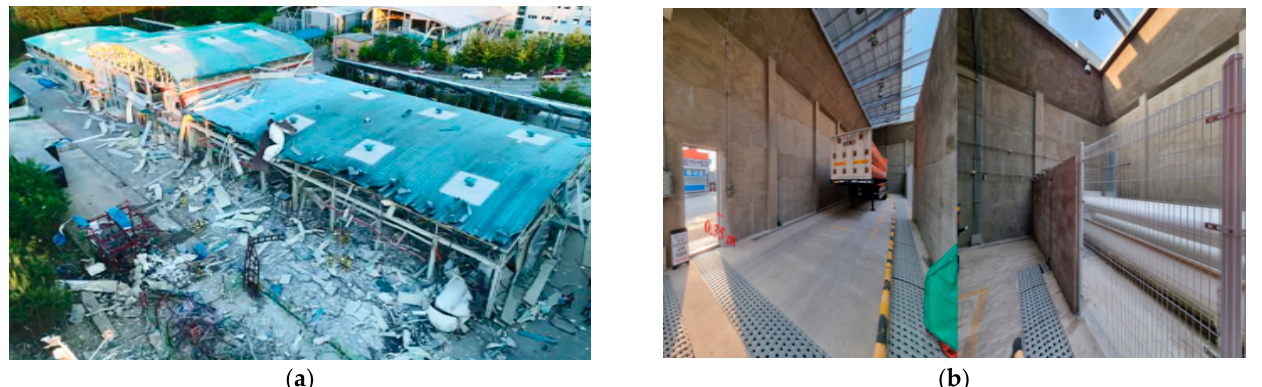
Figure 1. ( a ) Hydrogen tank explosion occurred in Gangneung, South Korea on May 2019; ( b ) Hy- drogen gas station site visit at Samcheok, South Korea. Table 1. Minimum requirement of barriers wall thickness in di ff erent countries [16,19]. Table 1. Minimum requirement of barriers wall thickness in different countries [16,19].